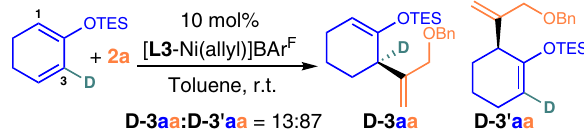
Fig. 5 Effect of chiral C 2 NHC – Ni(II) on 1,3-allylic shift. 1,3-allylic shift from 3- to 1-position is favored.